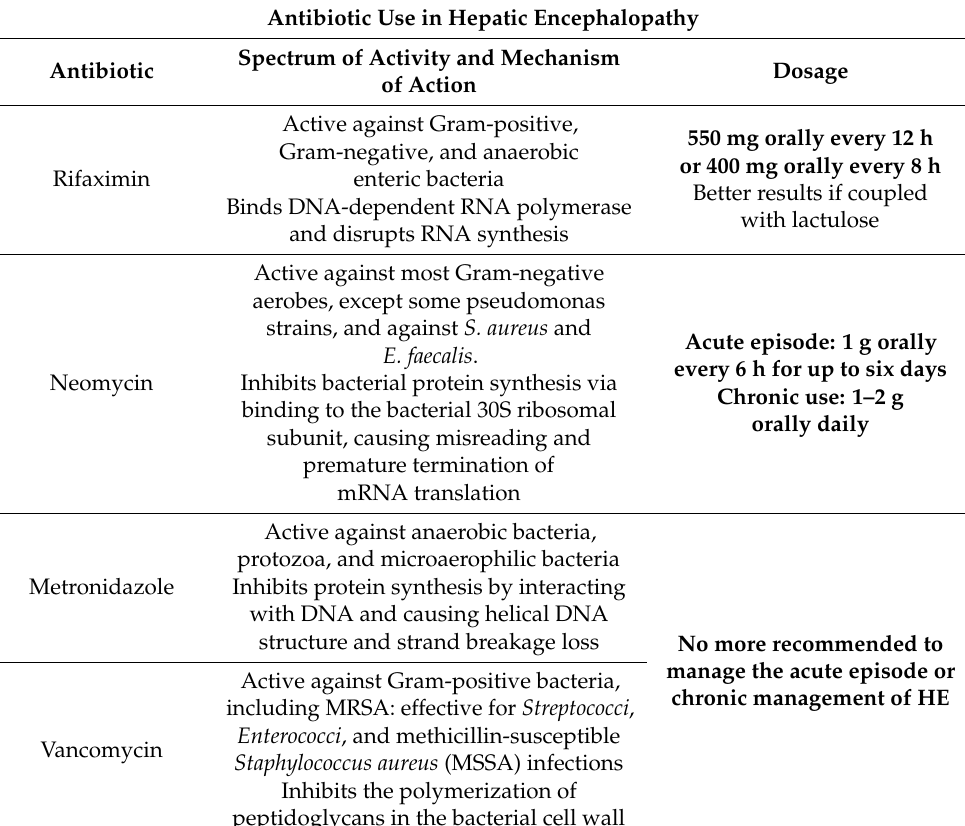
Table 2. Antibiotic use in hepatic